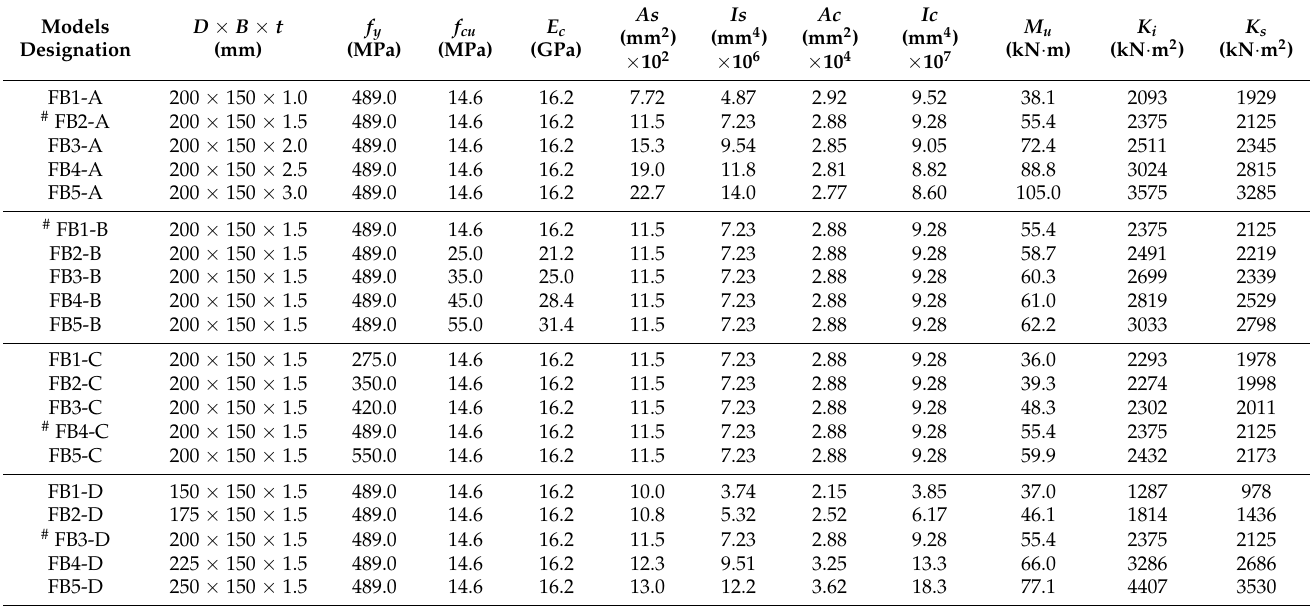
Table 3. FE model designations and analysis